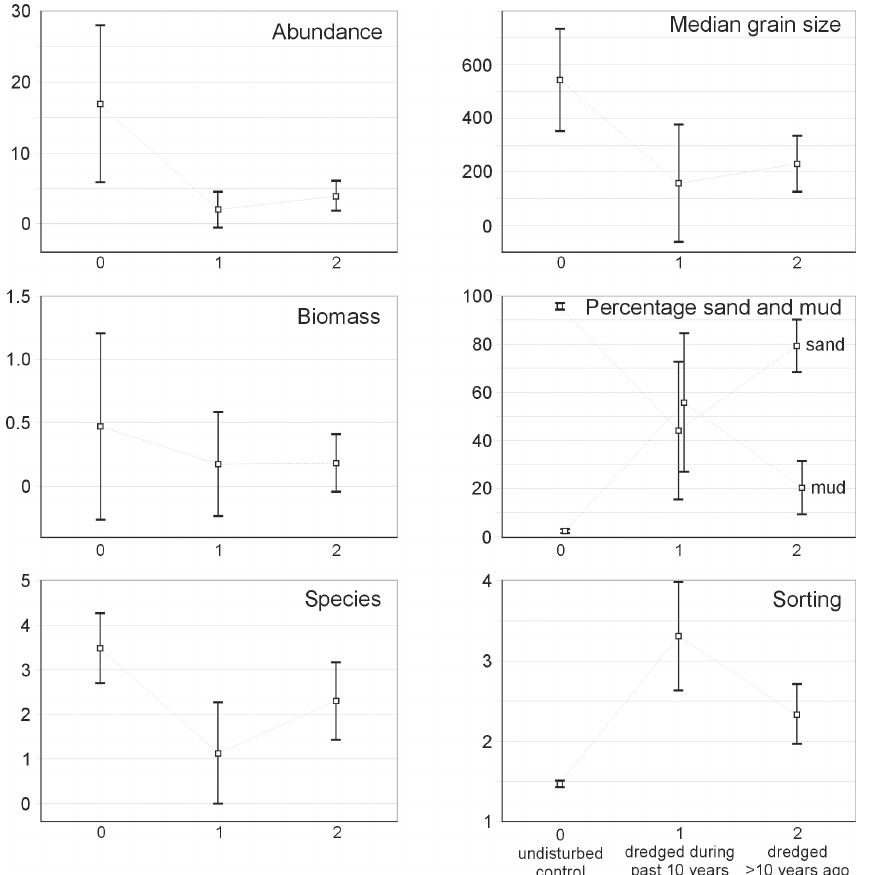
Figure 5. Macrozoobenthos abundance, biomass and species density per sediment core and sediment properties of sampling stations across the sediment extraction area: means and 95% confidence intervals and biomass in grams fresh weight. Site class 0 is control sites unaffected by sediment dredging; class 1 is sites dredged within the last 10 years; class 2 is sites > 10 years after dredging.